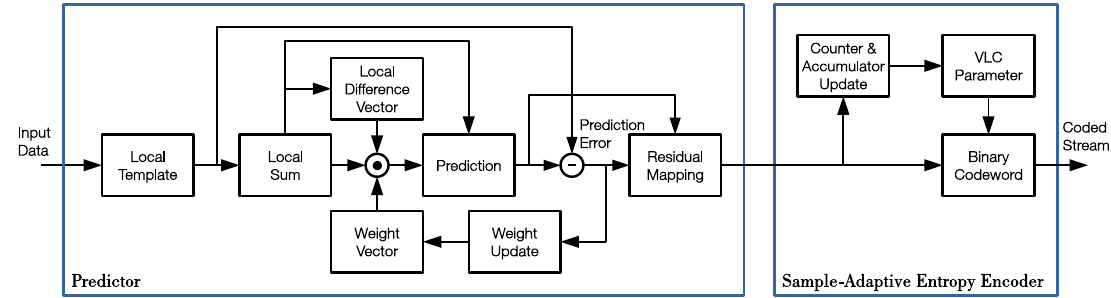
Figure 5. Block scheme of the lossless compression CCSDS 1.2.3